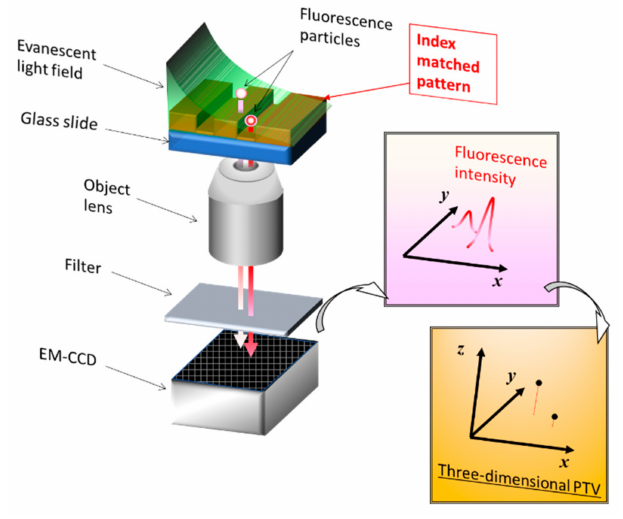
Figure 3. TIRF setting for